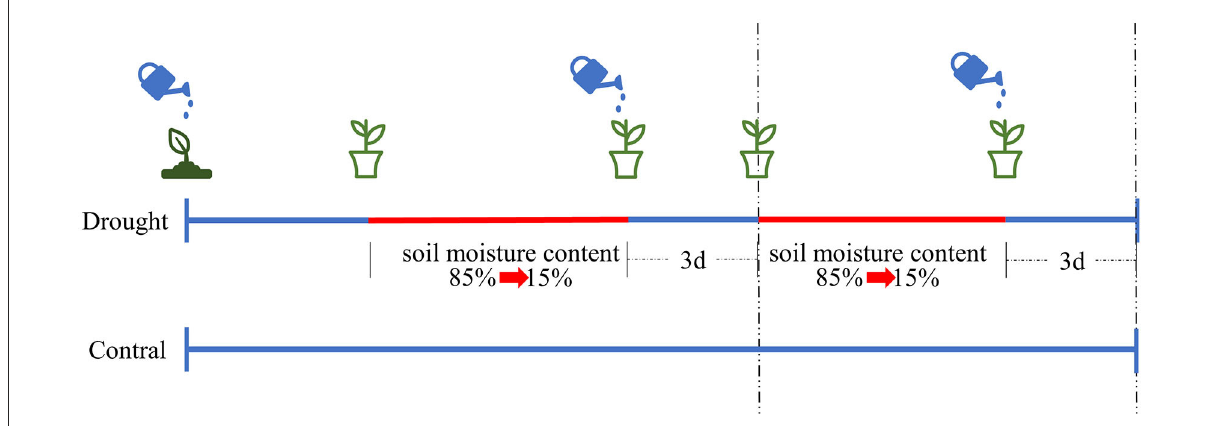
FIGURE1 Blue lines indicate adequate water supply, red lines indicate drought treatment, and dashed lines indicate the time of measurement to calculate seedling